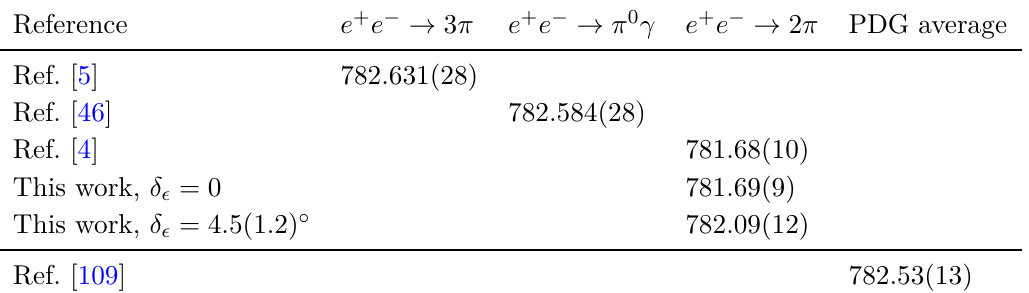
Table 5 . Dispersive determinations of M ω in MeV from e + e − reactions, compared to the global average from ref. [109]. In all cases, vacuum-polarization corrections are not included, and the average from ref. [109] has been adjusted accordingly using ∆ M ω = 0 . 13 MeV